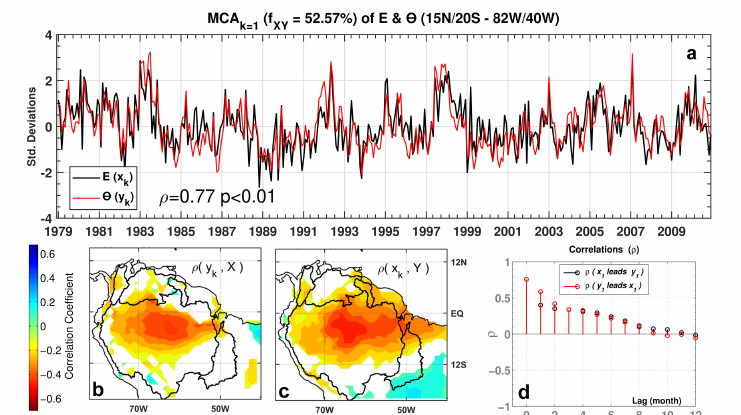
Figure 4. Leading MCA-mode between evaporation (X = E) and soil moisture (Y = Θ ). The spatial-pattern shows a core over the Amazon River basin. ( a ) MCA-series associated with this leading mode; ( b , c ) Spatial correlations-pattern of the MCA-mode as the influence of each variable in the other one ( d ) Lagged cross-correlations between MCA-series.